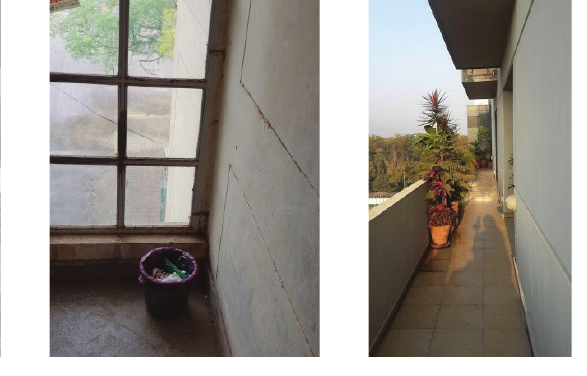
Figure 10. Front lawn in S.U. house